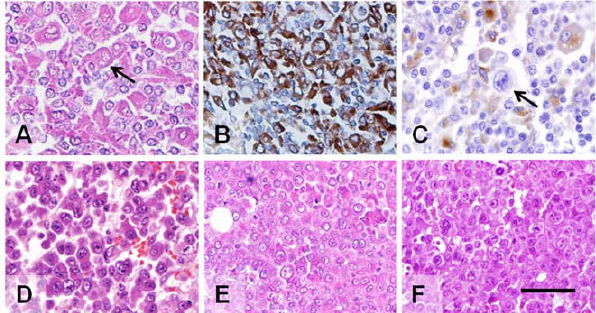
Figure 1. Microscopic morphology of the GW-532 human Hodgkin’s lymphoma and xenografts derived by serial trans- plantation in the hamster cheek pouch. (A) Sections of the original axillary mass showed involvement by a lymphohistiocytic infiltrate composed of small lymphocytes, histiocytes, and plasma cells. Rare atypical mononuclear cells with features of Hodgkin cells were identified (arrow, Hodgkin-Reed-Sternberg cell). Immunohistochemical labeling of the original human tumor identified cells of (B) B/monocyte- cell origin (CD74 + ), and (C) macrophages (CD68 + ). A Hodgkin cell (arrow) is negative for CD68. Uniform morphological characteristics of the xenograft tumors from generations 2 (D), 25 (E), and 115 (F) were constant over time. The individual cells are large with vesicular chromatin and prominent central nucleoli. Occasional cells with binucleate or bilobed nuclei are present. Scale bar within image F corresponds to 100 m m for all images.